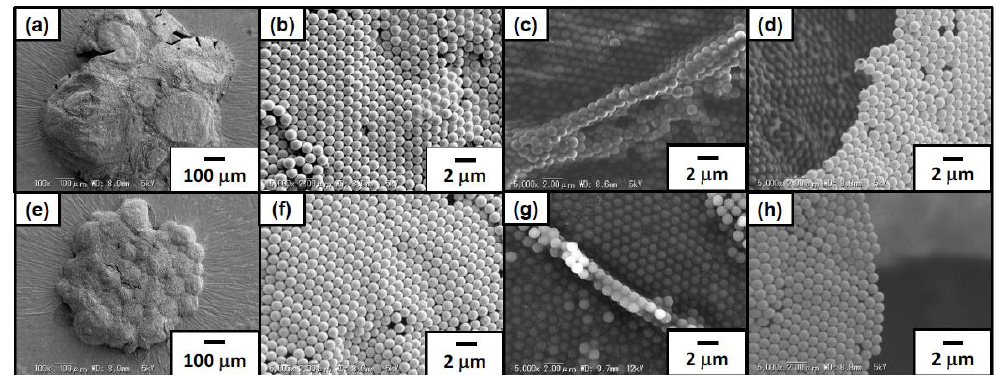
Figure 3. Scanning electron microscope (SEM) images of dried foams stabilized with ACMPA-PS